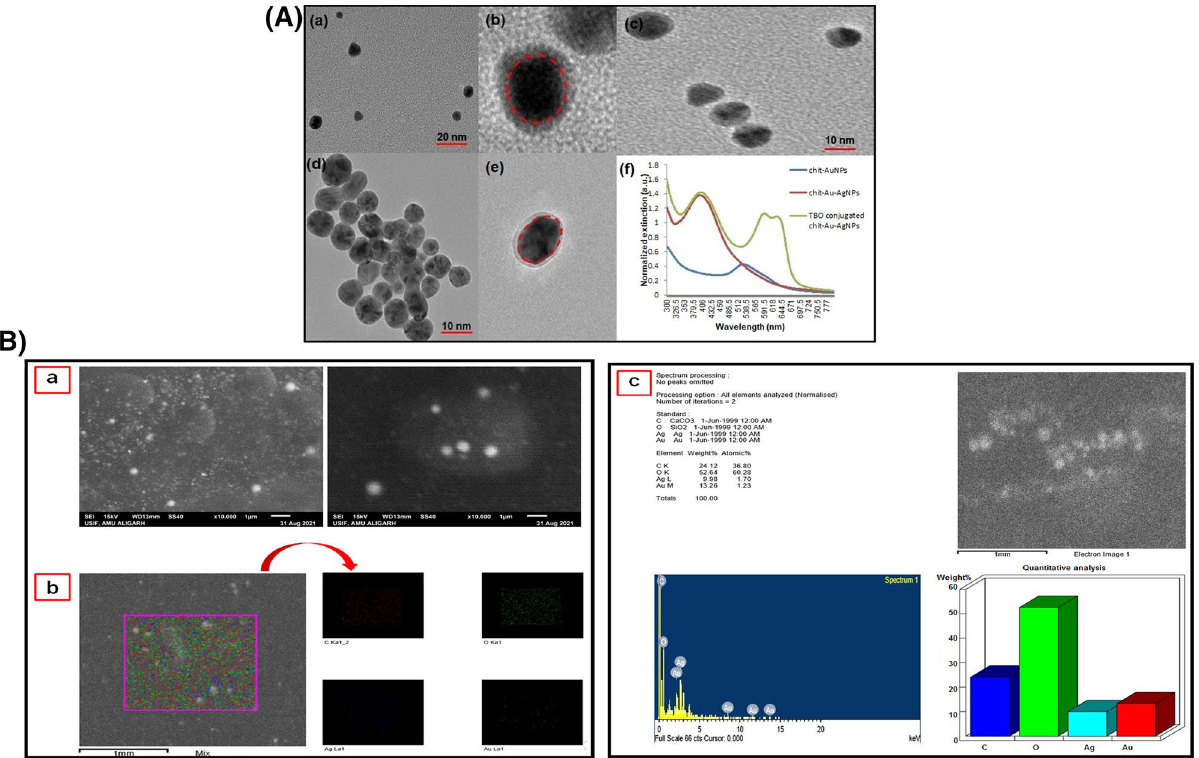
Figure 2. Characterization of nanoparticles: ( A ) (a) TEM image of spherical chit–AuNPs. (b)–(d) TEM images of chit–Au–AgNPs after additions of AgNO 3 aliquots. The interface between the Au–core and the Ag–shell was marked by a red dashed line in ( A (b)). (e) A closer view of an Au–AgNP coated by a chitosan layer. (f) UV–Vis absorption spectra of chit–AuNPs, chit–Au–AgNPs and TBO–chit–Au–AgNPs. ( B ) (a) Scanning electron microscopy (SEM) images of chit–Au–AgNPs, (b) Elemental distribution of Au, Ag, C and O in the sample (chit–Au–AgNPs) from Energy dispersive X-ray spectrometry (EDS) analysis, (c) EDS profile of chit–Au– AgNPs and quantitative analysis of Au, Ag, C and O in the